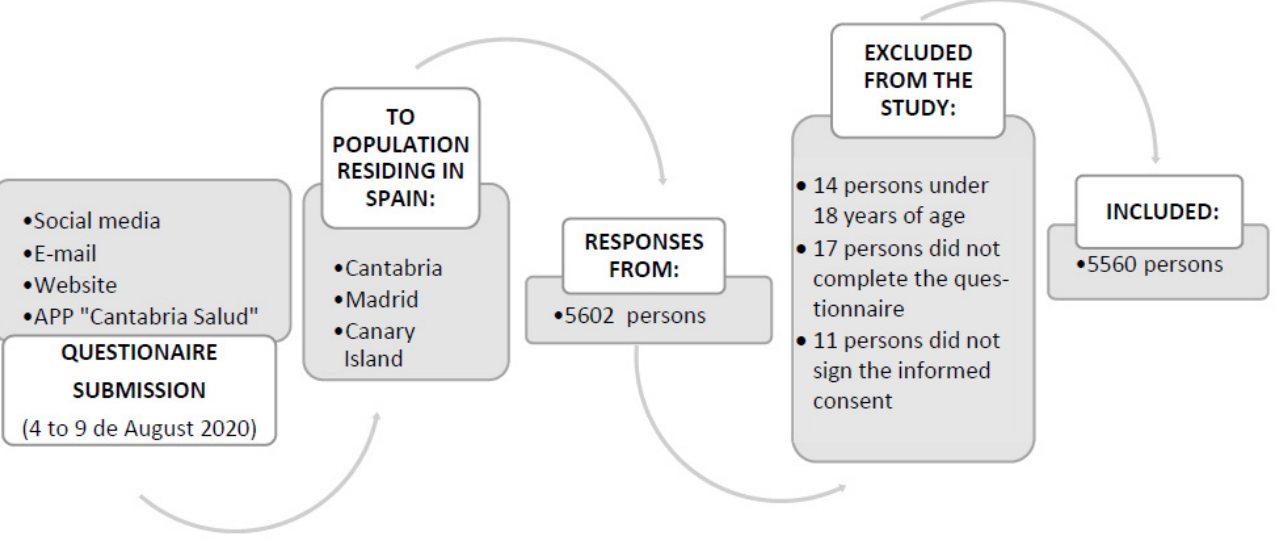
Figure 1. Sampling process.